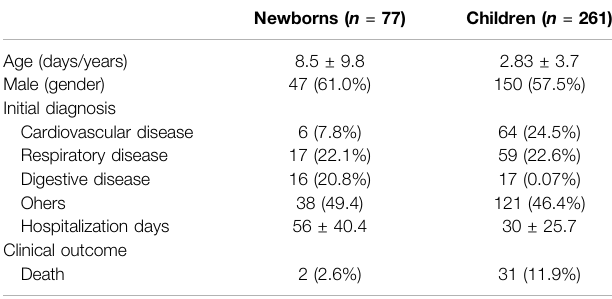
TABLE 1 | Baseline characteristics of included